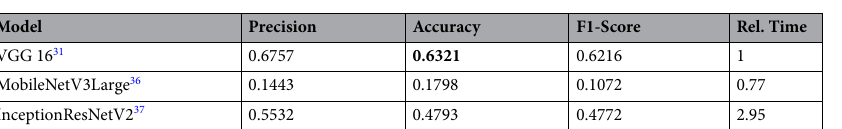
Table 3. Baseline study comparing different CNNs for visual feature extraction. Scores are averaged over a tenfold split and sample wise weighted to account for imbalanced data. The computing time required to evaluate a ten-fold split is set in relation to the time required for the VGG 16. The highest accuracy value is in [bold].